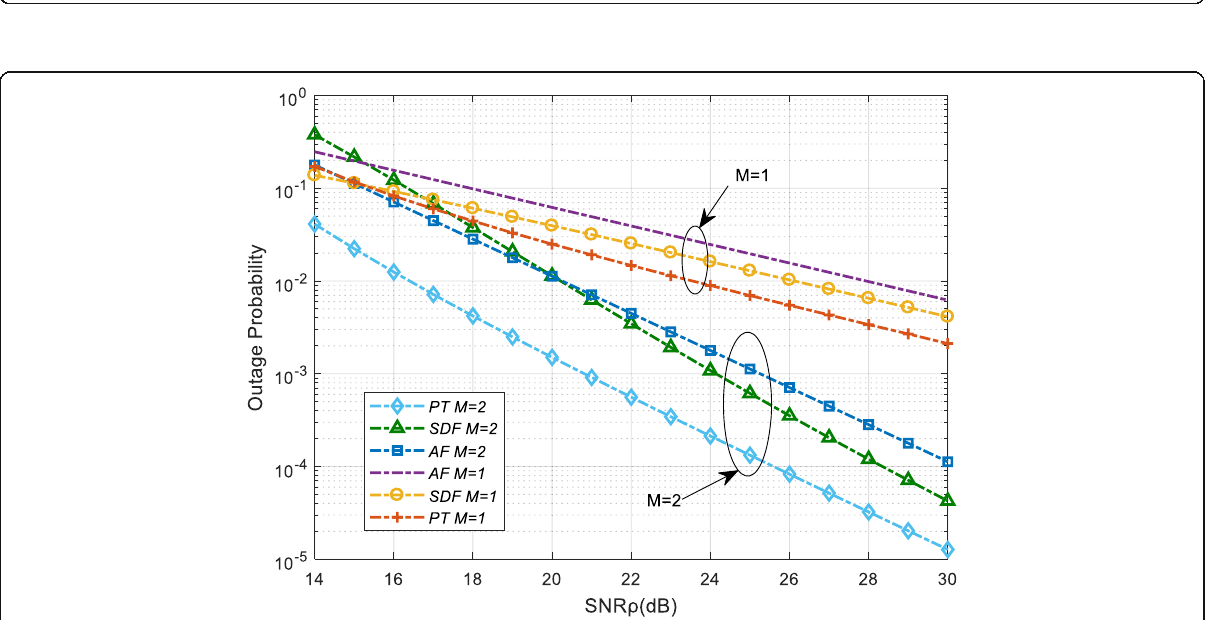
Fig. 9 Outage probability versus channel gain between relay and destination without direct link. The figure shows that the simulations on outage probability versus SNR of partial transmission (PT) and three conventional cooperative strategies, direction transmission (DT), selective decode-and- forward (SDF), and amplify-and-decode (AF) without the existence of direct link, on the situations with one-relaying system and two-relaying system. To simulate the unreliable relays, the simulation parameters are set as: the number of information bits is 100,000; the transmission rate of information is 0.5b/s/Hz; the channel states from relays to destination is set as 0.2, and those from source to relays and source to destination are set the same, as 0.1. At low SNR, Fig. 9 shows none of the mentioned strategies are reliable. As SNR increases, the improvements of PT are more obvious without direct link. Certainly, the existence of the direct link helps to gain more spatial diversity gain, which can be seen when compared to Fig.